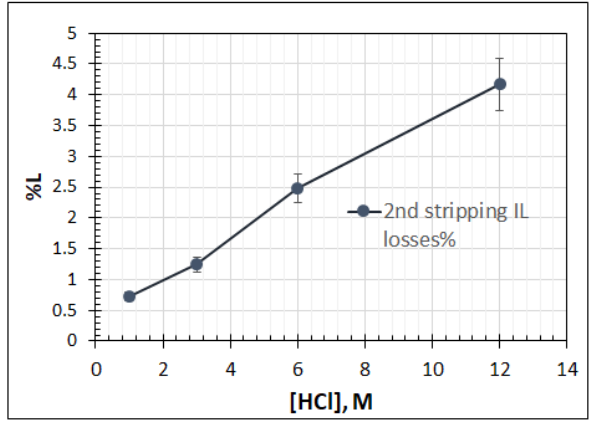
Table 2. Comparison of the different concentration in metals in the different streams from the pro- posed stripping processes. Figure 6. Ionic liquid losses % during the second stripping experiments. Figure 6. Ionic liquid losses % during the second stripping experiments.